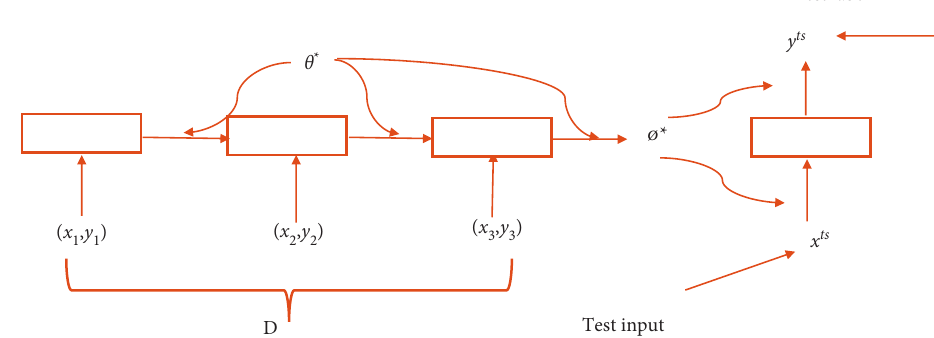
Figure 1: A simplified interpretation of metalearning